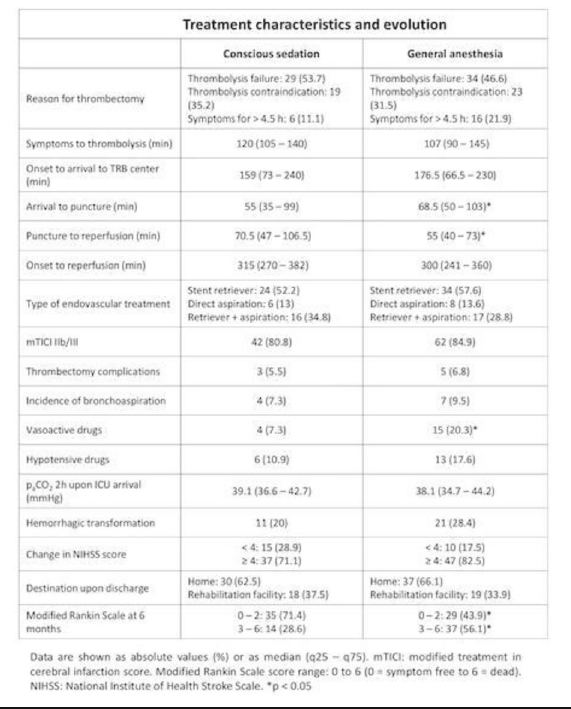
Intensive Care Medicine Experimental 2018, 6 (Suppl